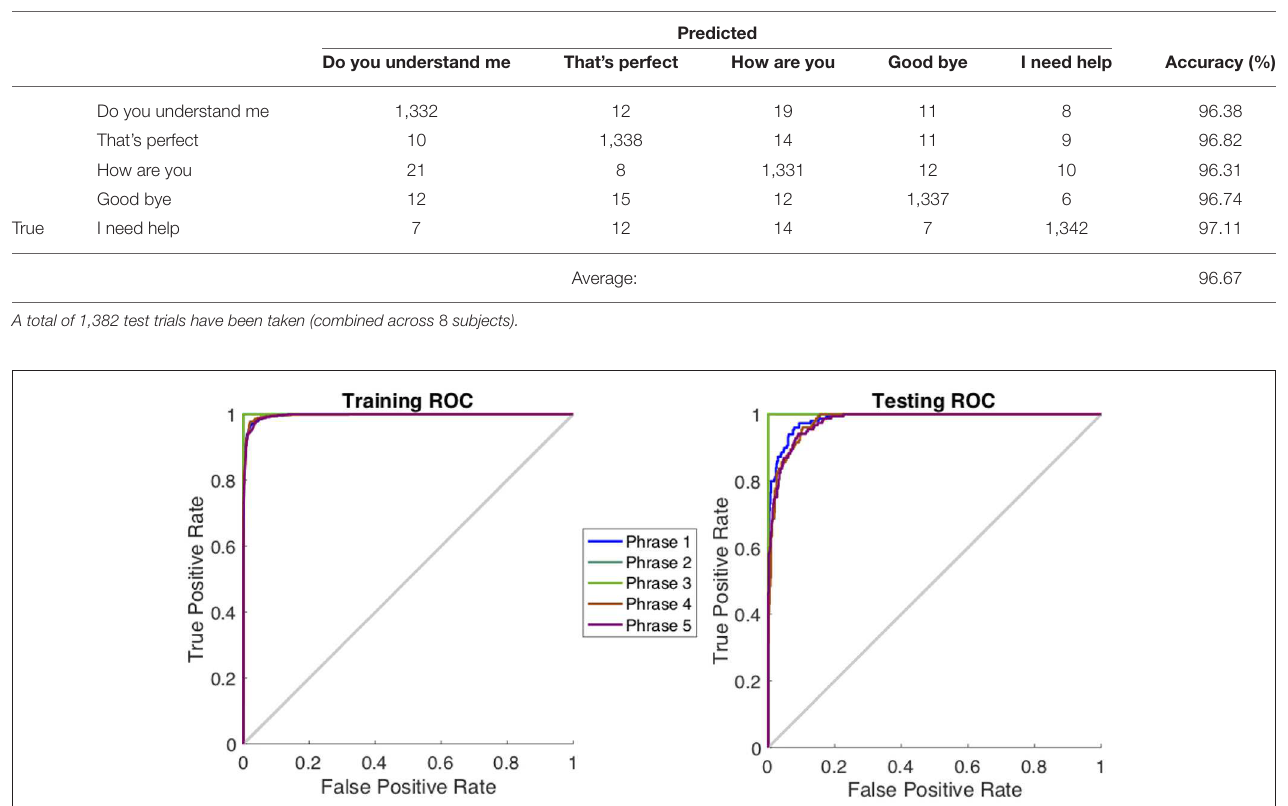
TABLE 2 | Test confusion matrix for speech decoding accumulated across all subjects during articulation stage.